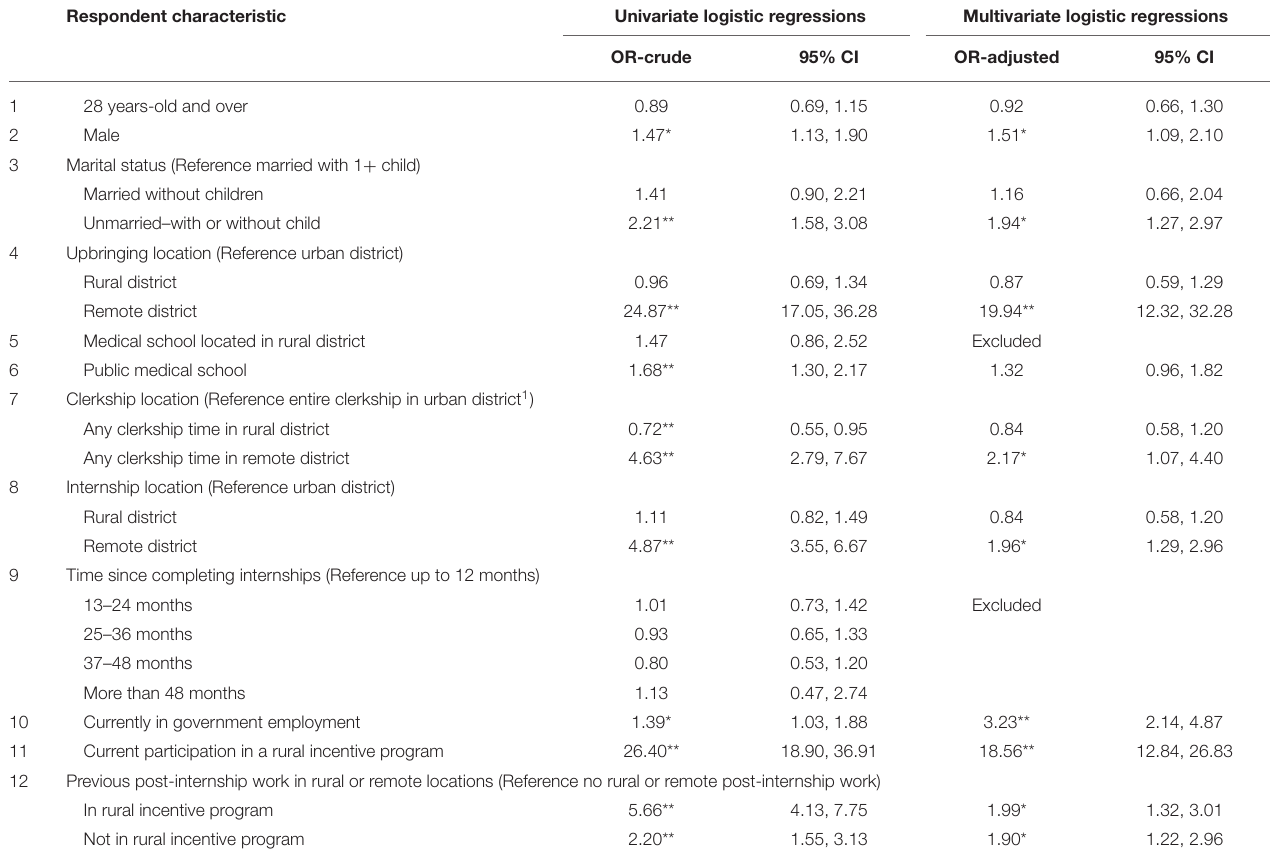
TABLE 2 | Odds ratio of working in remote districts ( n = 3,176). Respondent characteristic Univariate logistic regressions Multivariate logistic